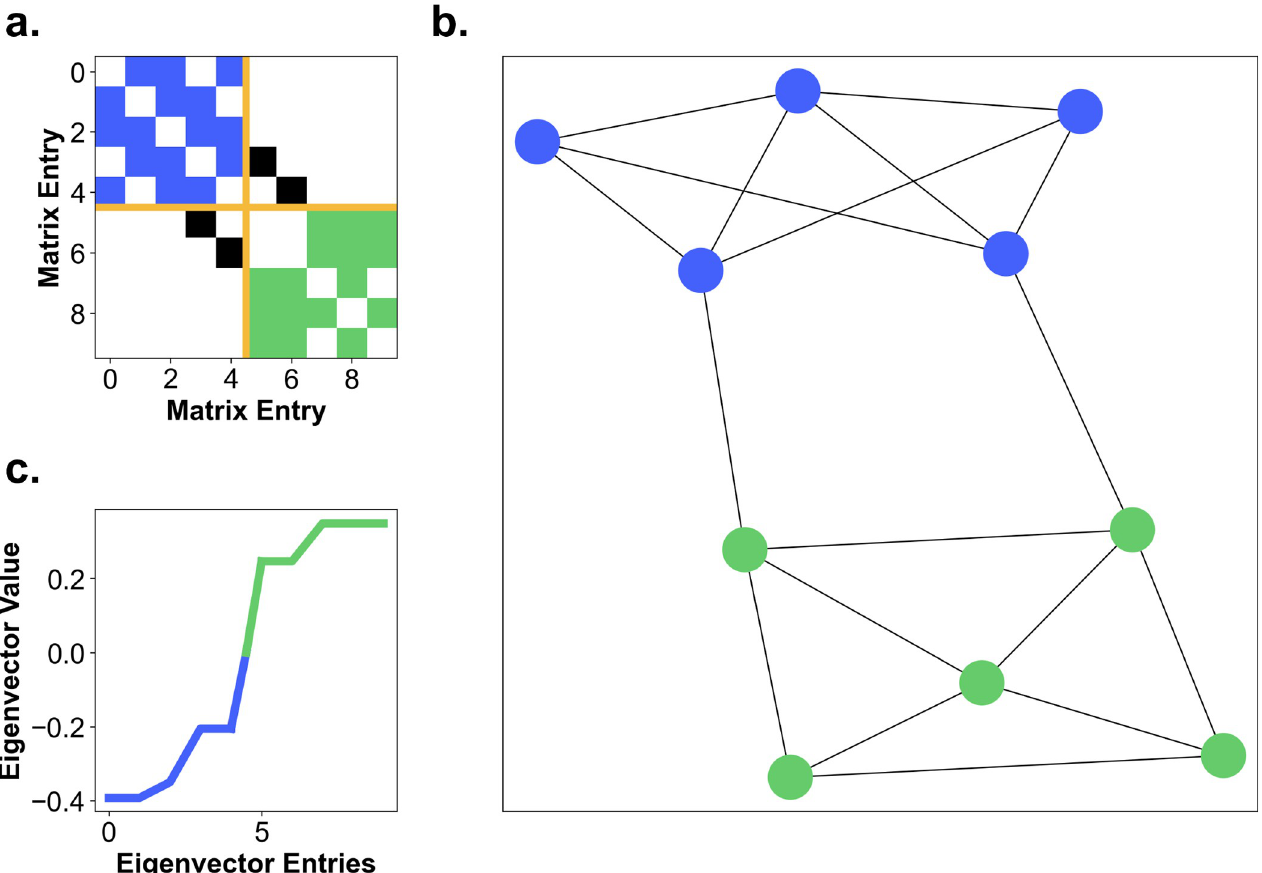
Fig 12. Graph partitioning–Toy example. (a) The sparsity pattern of the graph’s adjacency matrix sorted by its second smallest eigenvector. Color coded into edges between nodes of one cluster (blue), edges between nodes of the other cluster (green), edges between nodes of the two clusters (black) and a distinction between the clusters (yellow). (b) The toy graph with two color coded clusters. (c) The second smallest eigenvector of the Laplacian matrix is sorted ascendingly and color coded into two clusters by division into positive and negative components.